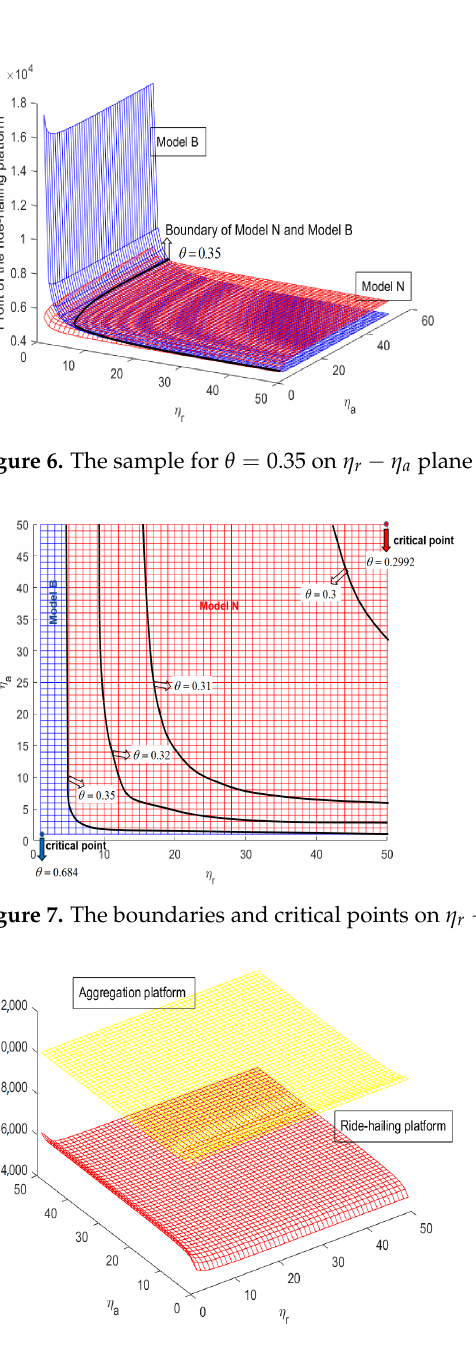
Figure 8. The profits of platforms with the combinations of η r and η a in Model